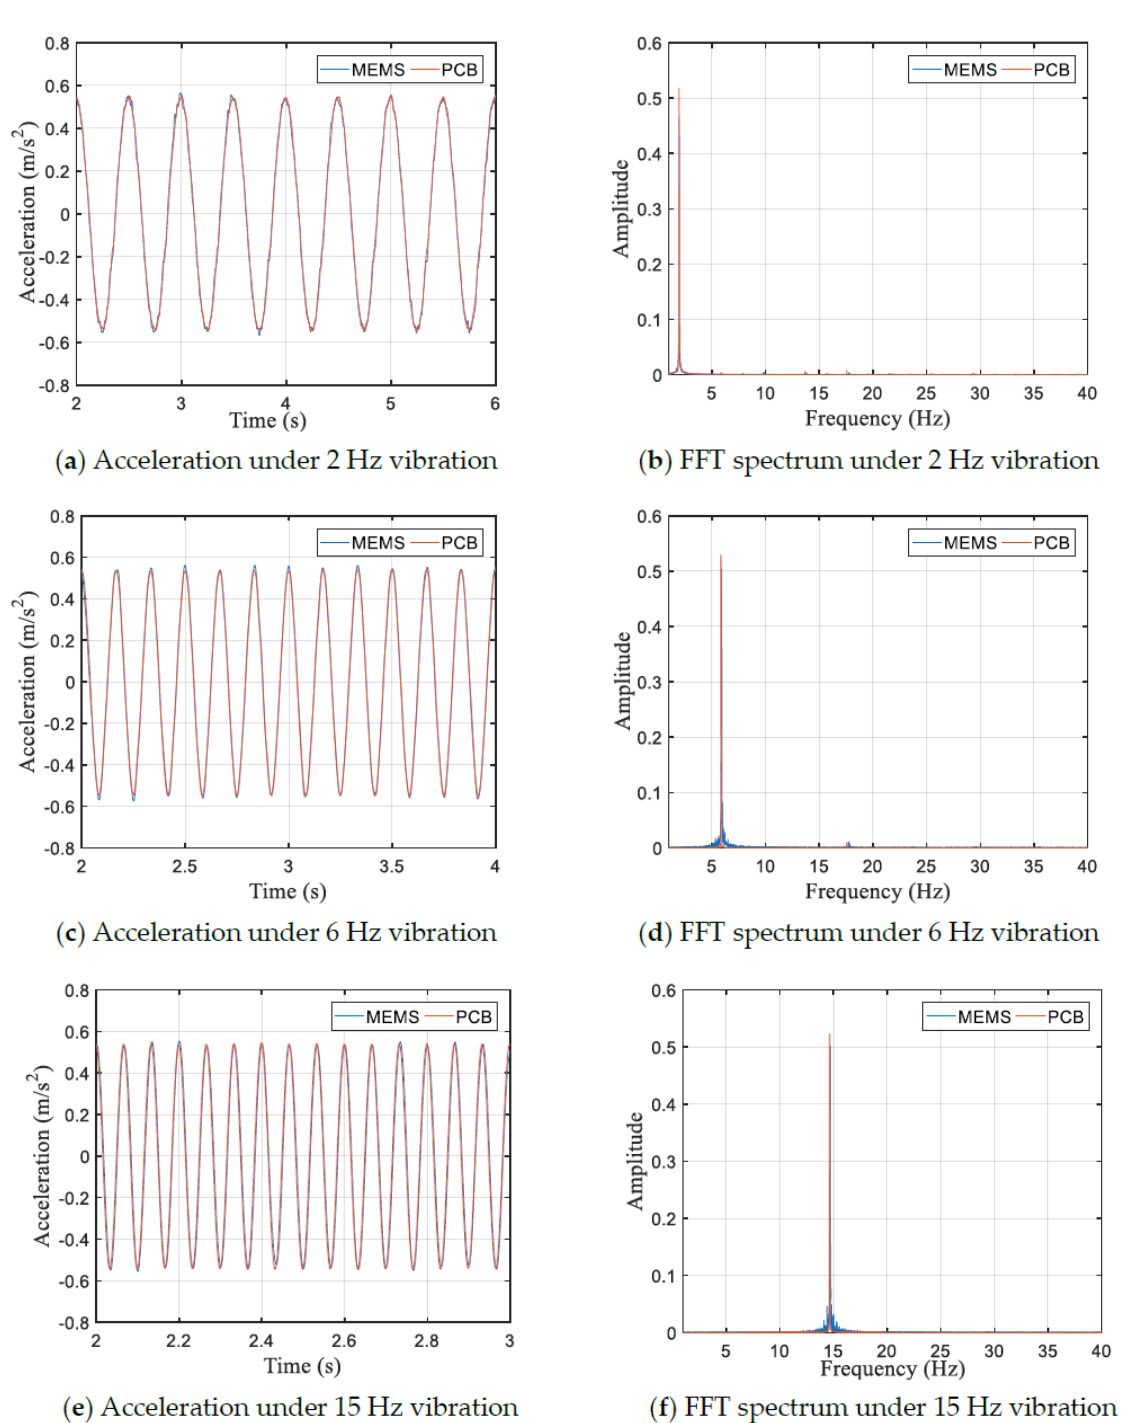
Figure 11. Measured acceleration time histories and fast Fourier transform (FFT) spectra by MEMS and PCB accelerometers with the excitation level 0.05